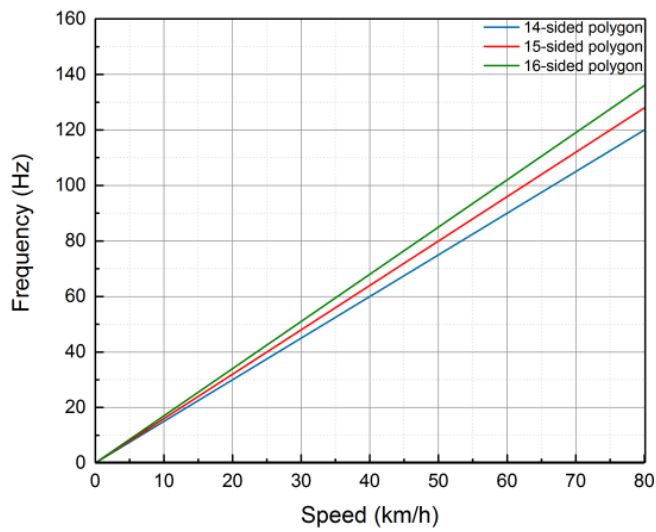
Figure 13. Relationship between wheel polygon and running speed.